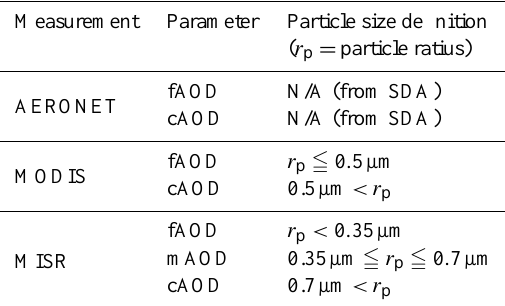
Table 3. Definitions of fAOD, mAOD and cAOD. See Table 1 for the AOD acronyms. Only the MISR algorithm gives